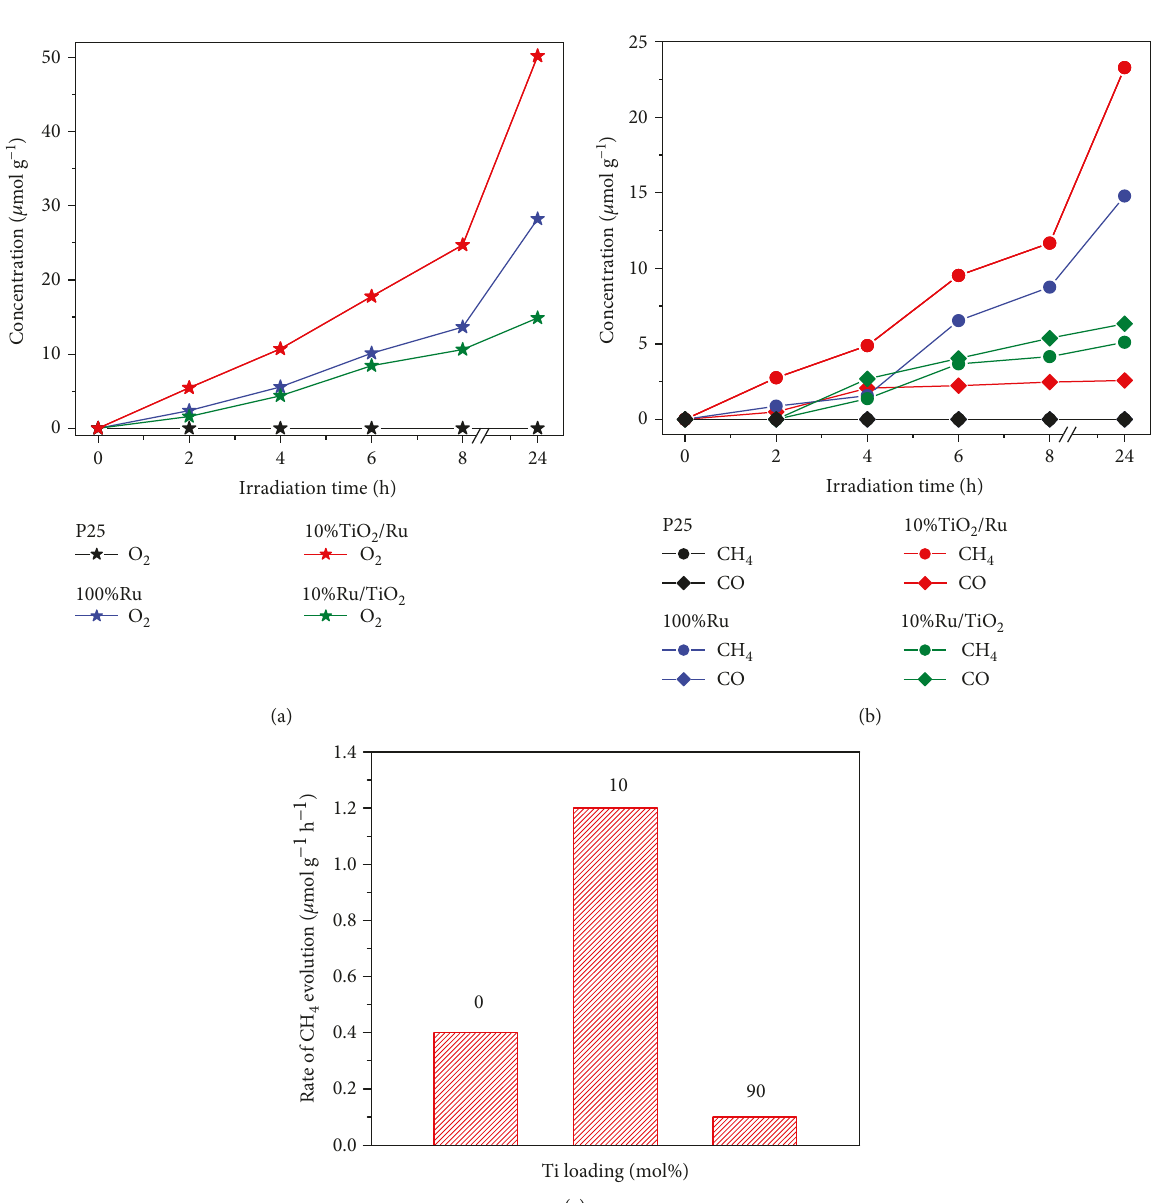
and (b) CH and CO with time over P25 and the three Ru-containing catalysts and (c) rate of CO 2 4